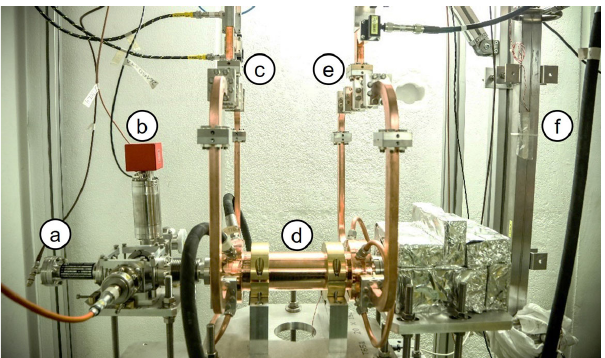
FIG. 2. Picture of a prototype accelerating structure installed in one of the test stands [16]. Visible are the upstream Faraday cup (a), an ion pump (b), the rf input (c) and output (e), the rf cavity under test (d), the shielded lead enclosure (f), and the high-power rf load (g). 1